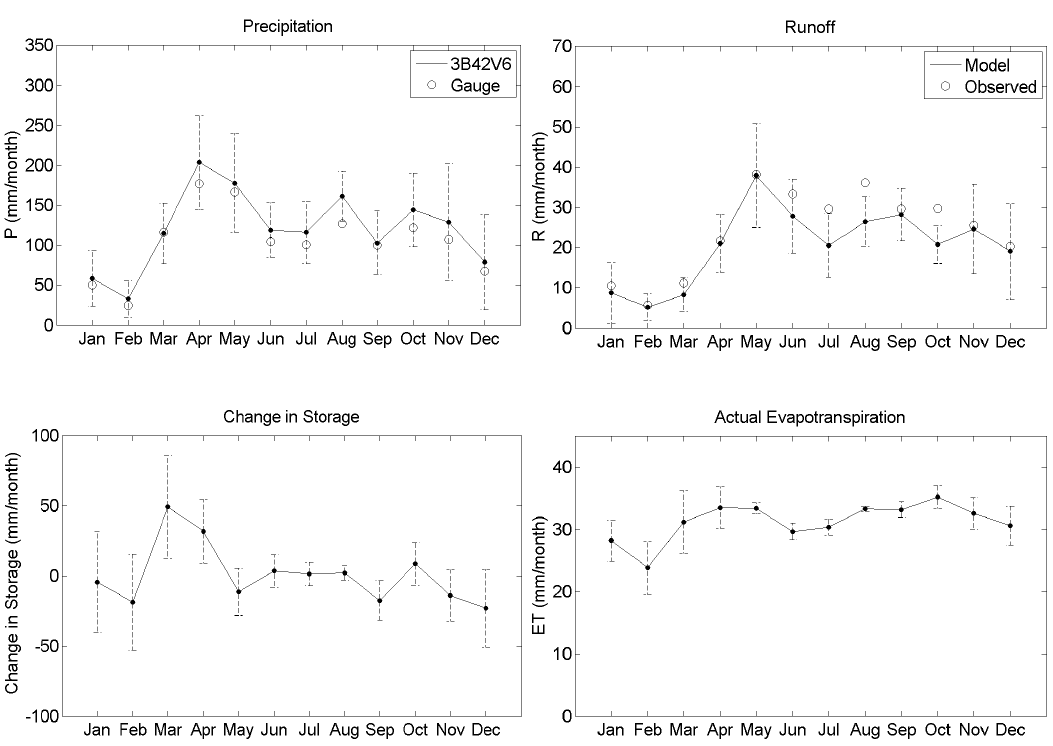
Fig. 6. Monthly model versus observed Runoff ( R ), Precipitation ( P ), Evapotranspiration (ET) (mean annual cycle 1996–2006). Error bars showing the ± 1 std dev of monthly mean values.